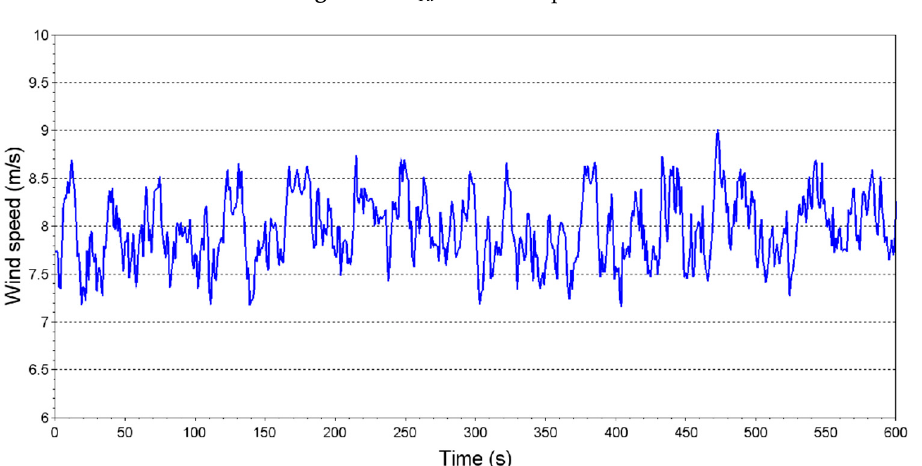
Figure 16. (cid:1848) (cid:3019)(cid:3036) reference update. Figure 16. V Ri reference update.